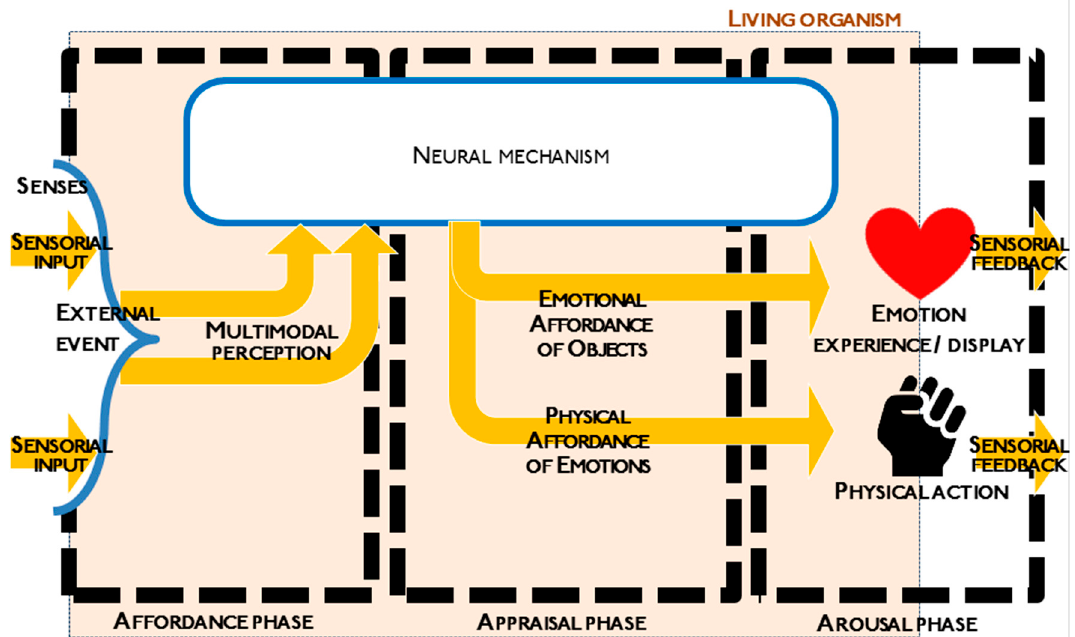
Figure 1. Affordance-Appraisal-Arousal model applied to humans or more generically to living organisms. For robots, we apply the same structure, except that the area marked in the light blue box in Figure 2 consists of the components of the library, which interface with the robot (in dark grey).